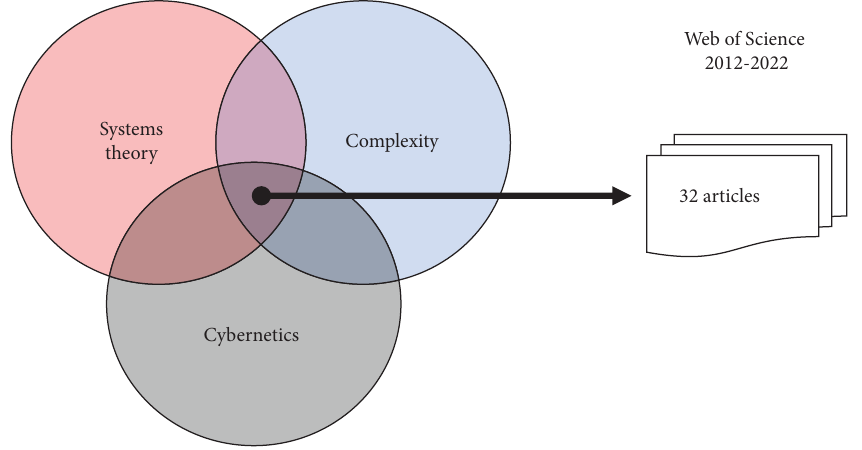
Figure 3: Review method used for the application